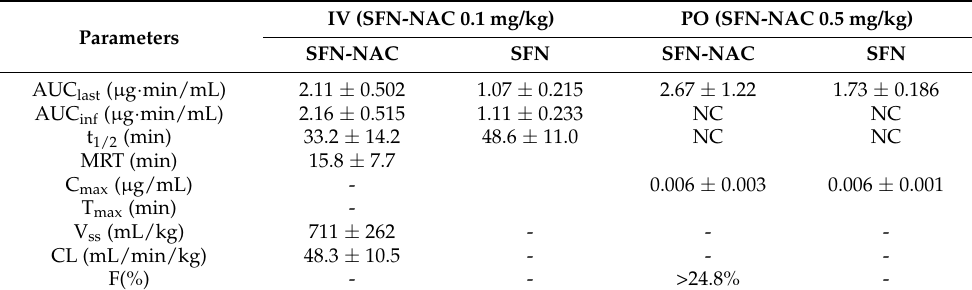
Figure 9. Plasma concentration of SFN-NAC and SFN after ( a ) intravenous (0.1 mg/kg) and ( b ) oral (0.5 mg/kg) administration of SFN-NAC to rats. Data values are expressed as means ± standard deviation ( n = 4). SFN, sulforaphane; SFN-NAC, sulforaphane N -acetylcysteine. Table 2. Pharmacokinetic parameters of SFN-NAC and SFN after intravenous (0.1 mg/kg) and oral (0.5 mg/kg) administration of SFN-NAC to rats. The data are expressed as the mean ± standard deviation ( n = 4).